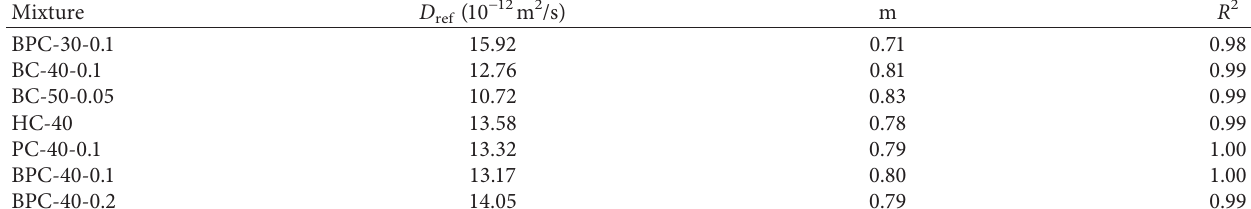
Table 5: Reference chloride diffusion coefficient and time-dependent coefficient of BPFRC.